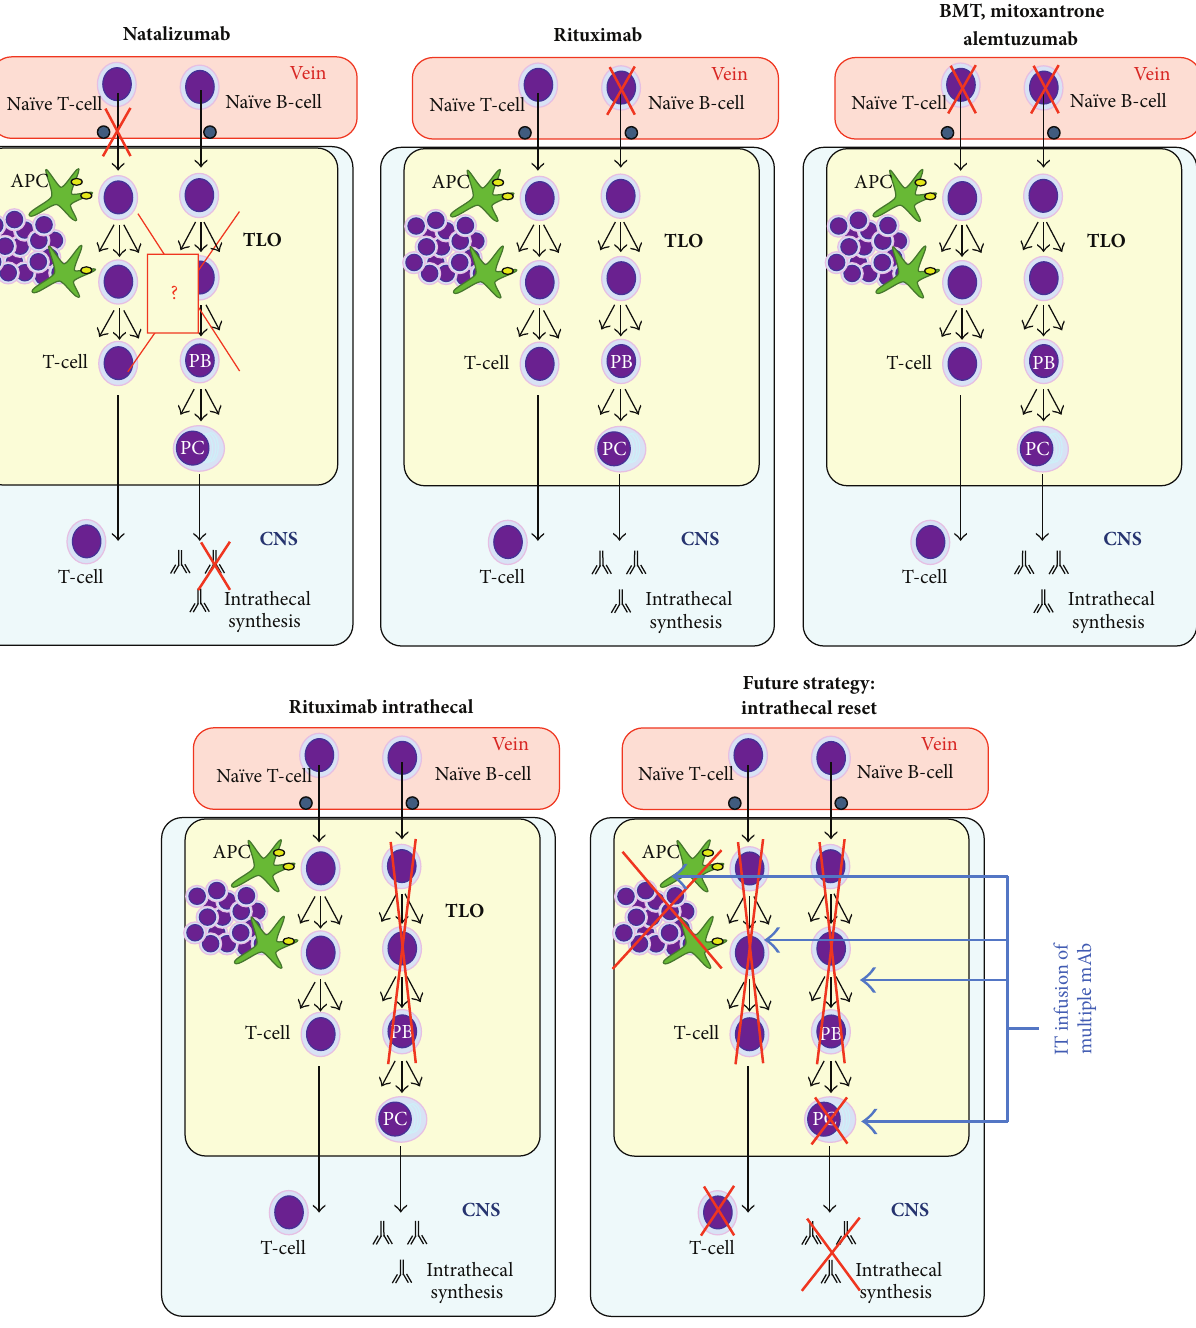
Figure 1: Schematic targets of MS treatments upon CNS compartmentalized inflammation, especially in tertiary lymphoid organs (TLO). Exceptfornatalizumab(owingtounclearmechanisms),noneofthetreatmentstargetingbloodB-cellshaveshownanyactionuponintrathecal IgG synthesis. Preliminary results suggest that rituximab also fails to reduce IgG synthesis. Future treatment strategies might be redirected to reset all the components of intrathecally compartmentalized inflammation. APC: antigen-presenting cells; BMT: bone marrow transplant; PB/PC: plasmablasts/plasma cells; TLO: tertiary lymphoid